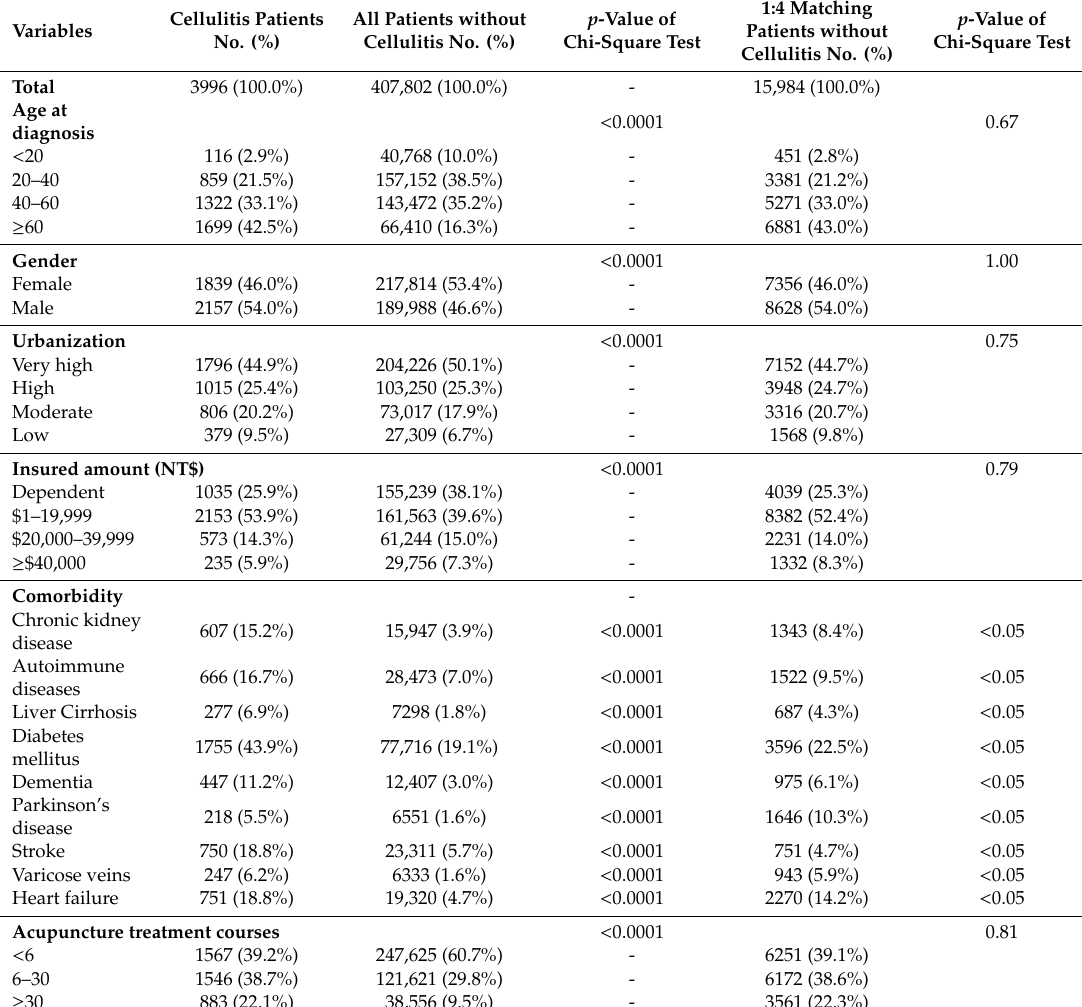
Table 1. Demographic and medical feature of patients with cellulitis after